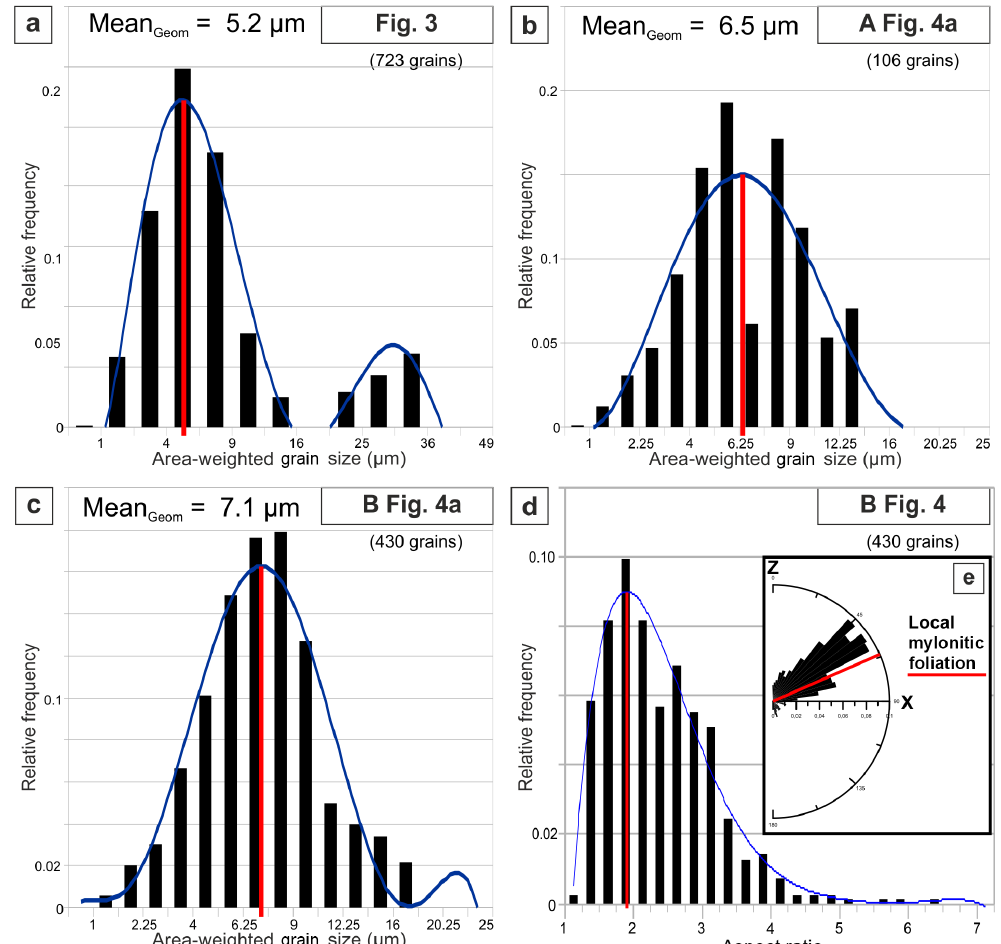
Figure 8. Area-weighted grain-size distributions and SPO for Plg. (a) Grain-size distribution for Plg in myrmekite of Fig. 3. (b) Grain-size distribution for Plg in incipient myrmekite A in Fig. 4a. (c) Grain-size distribution for Plg in sheared myrmekite B in Fig. 4a. (d) Relative frequency distribution of grain aspect ratio for Plg. (e) Rose diagram showing the orientation of major axis of Plg grains, defining a weak SPO. The distribution curve (blue line in grain-size distribution diagrams) was obtained by interpolating distribution data with a sixth-degree polynomial equation in MS Office Excel. Relative frequencies are normalized to